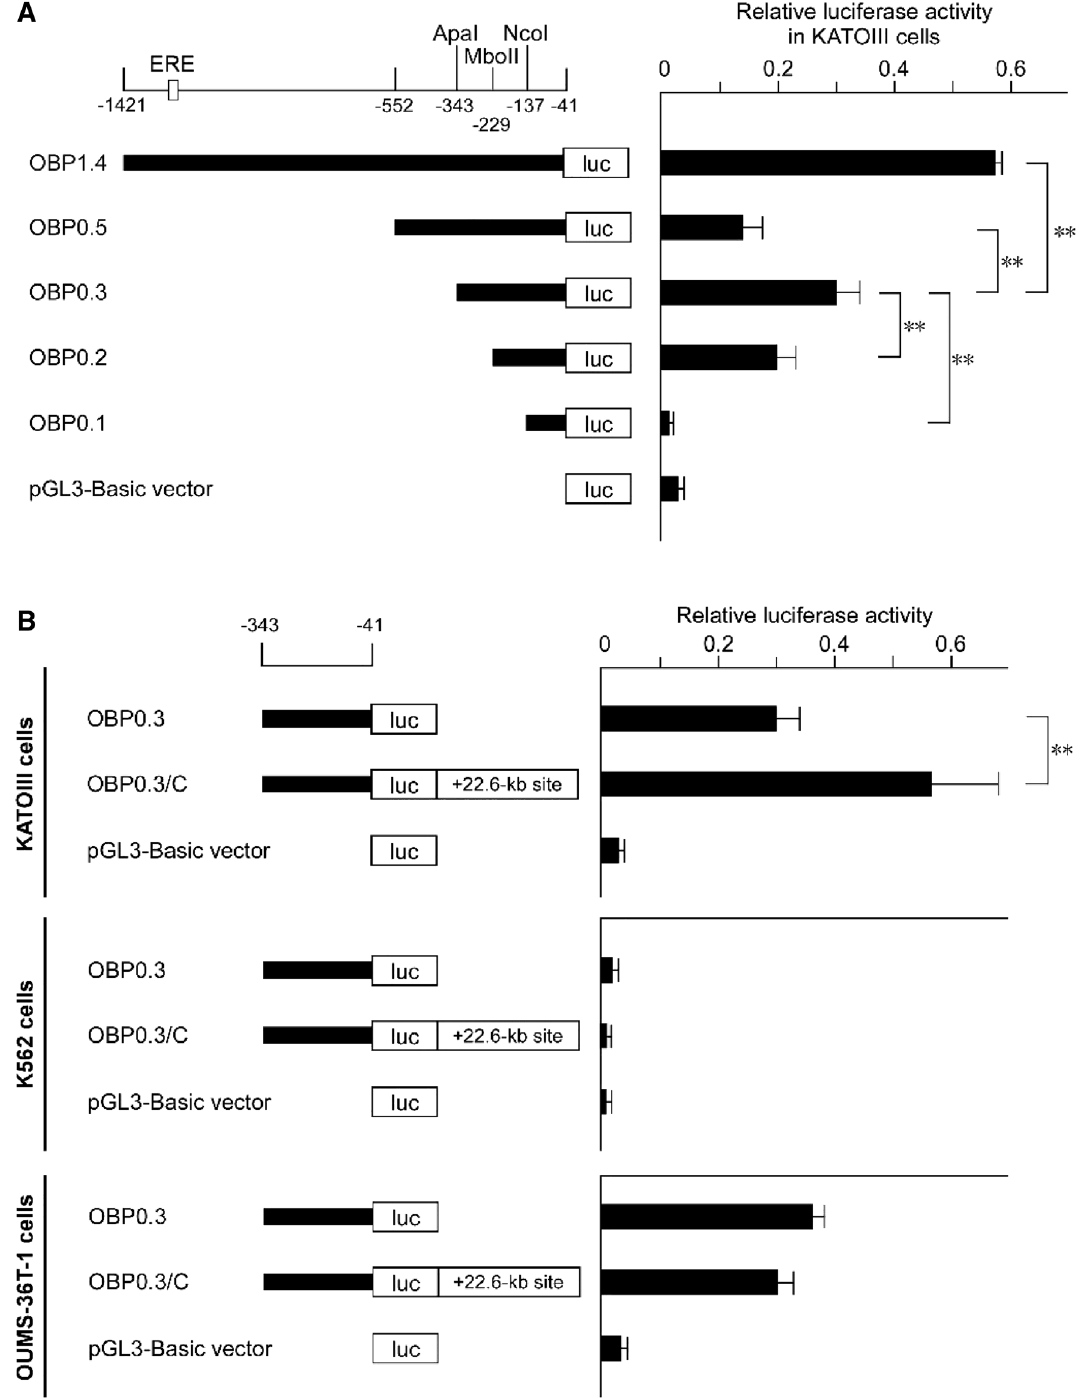
Figure 5. Summary of the relative luciferase activities of the reporter constructs containing different lengths of the 5 ′ upstream sequence of OBP2B . The OBP2B sequences (horizontal bars) were inserted upstream of the luciferase coding sequence of the pGL3-basic vector. Constructs were aligned below the restriction map of the region and are shown in the left panel. ERE represents location of estrogen response element. Construct names are shown to the left of the bar, and the locations of the inserted fragments are shown. The + 22.6-kb site was inserted downstream of luciferase in construct OBP0.3/C. Each construct as depicted on the left was transiently transfected into KATOIII cells in ( A ), and each construct was transiently transfected into KATOIII cells, K562 cells, or OUMS-36T-1 cells in ( B ). The obtained luciferase activity was normalized, and is shown in the right panel. The mean values and standard deviations were calculated from more than three independent experiments. The significance of differences was determined by Student’s t test at a significance level of p < 0.01 (**). The activity of the pGL3-promoter vector containing the SV40 promoter was given an arbitrary value of